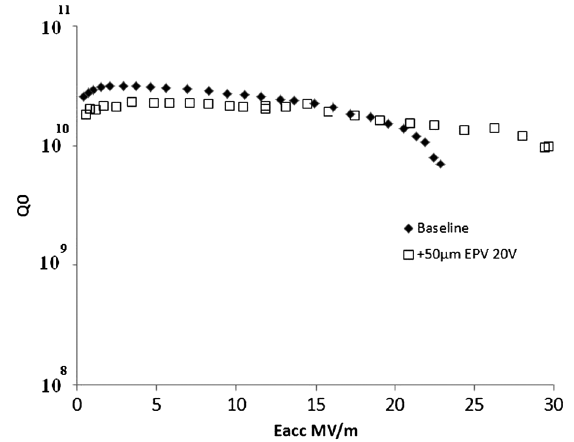
FIG. 18. Radio-frequency test of C1-21 cavity after VEP, Argon baking (3 h 145 (cid:3) C ) and HPR.